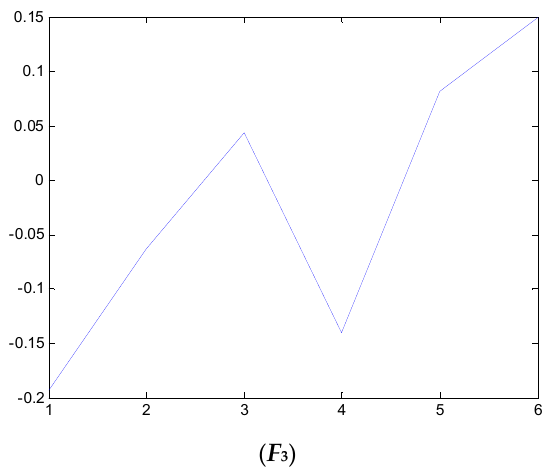
Figure 14. The analyzed results of A fan No. 2H sensor by F 1 , F 2 and F 3 .